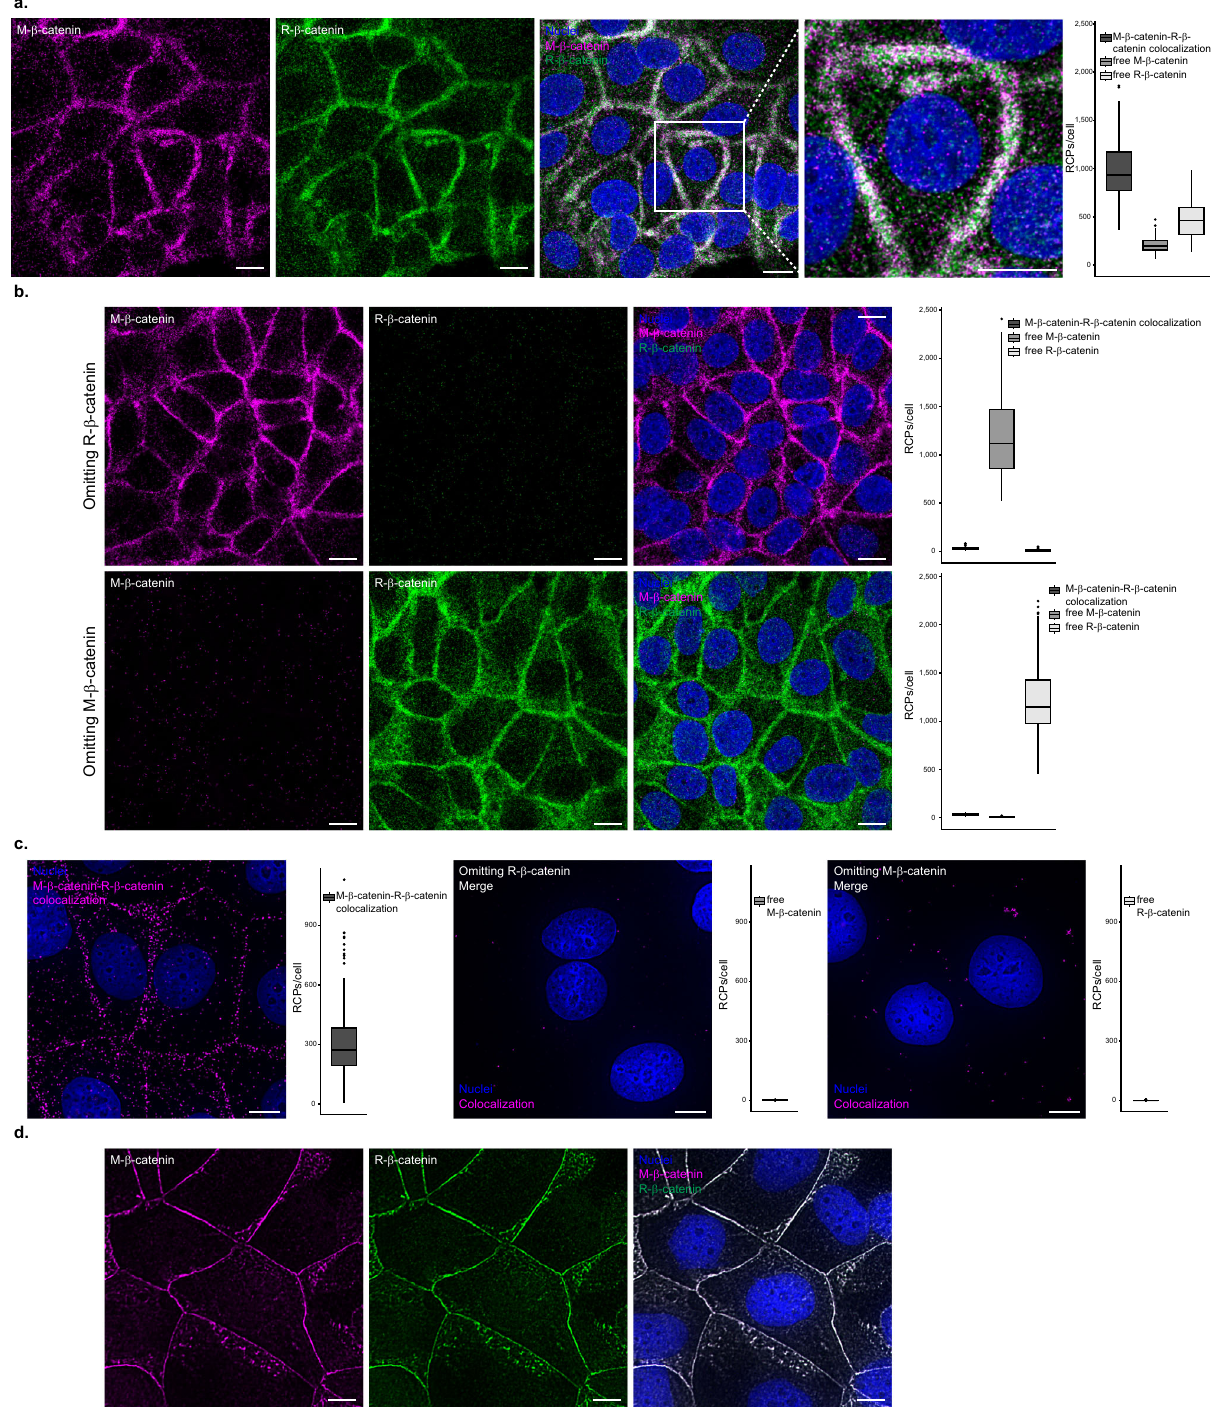
Fig. 2 | Single protein targeting and antibody validation. a MolBooleanstaining and quanti fi cation with twoantibodies, one raised inmouse(M, magenta),andthe otherraisedinrabbit(R,green),againstdistinctepitopesof β -catenininMCF7cells. Dual staining is shown in white and Hoechst33342 staining of nuclei is shown in blue. b MolBoolean technical controls, in which either one of the primary anti- bodies was omitted from the reaction mix. c In situ PLA colocalization staining, omitting controls and quanti fi cations with the same pair of anti- β -catenin anti- bodies in MCF7 cells. In situ PLA signals are shown in magenta and nuclei in blue. d Immuno fl uorescent staining of MCF7 cells with the same pair of anti- β -catenin